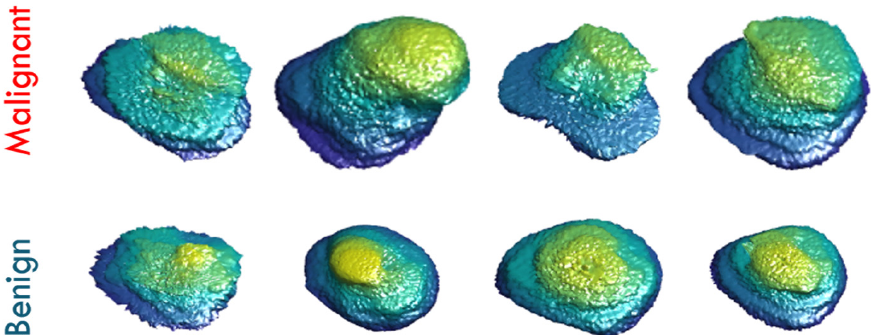
Figure 8. Visualization 3D shape differences between four malignant cases in the first row, and four benign cases in the second row.